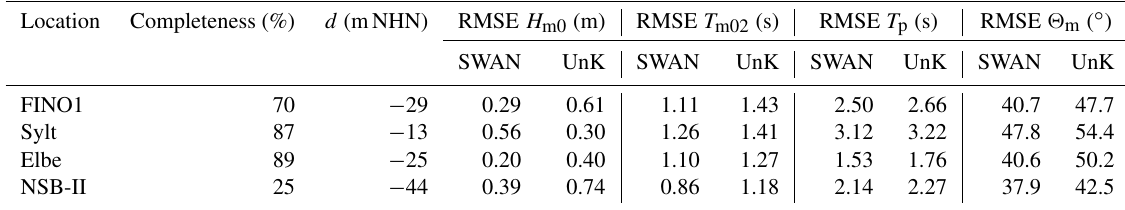
Table 2. Root mean square error (RMSE) of the significant wave height ( H m0 ), mean wave period ( T m02 ), peak wave period ( T p ), mean wave direction ( (cid:50) m ), water depth ( d ), and completeness of the measured significant wave height at selected locations for the year 2007.